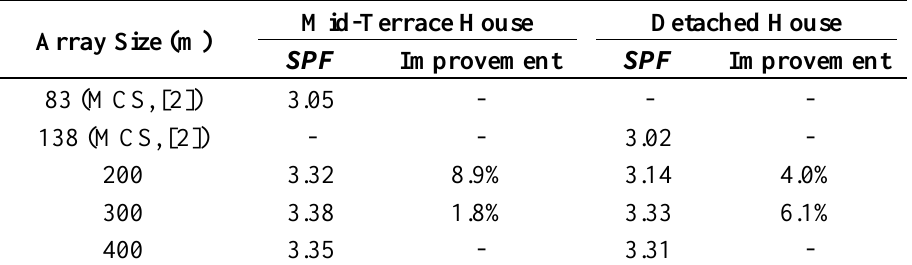
Table 3. Design array sizes and corresponding heat pump SPF